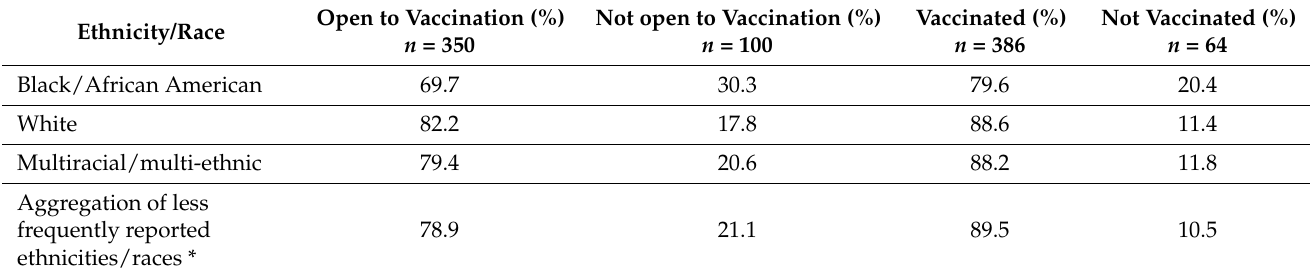
Table 2. Baseline attitudes to vaccination and vaccination status of participants by